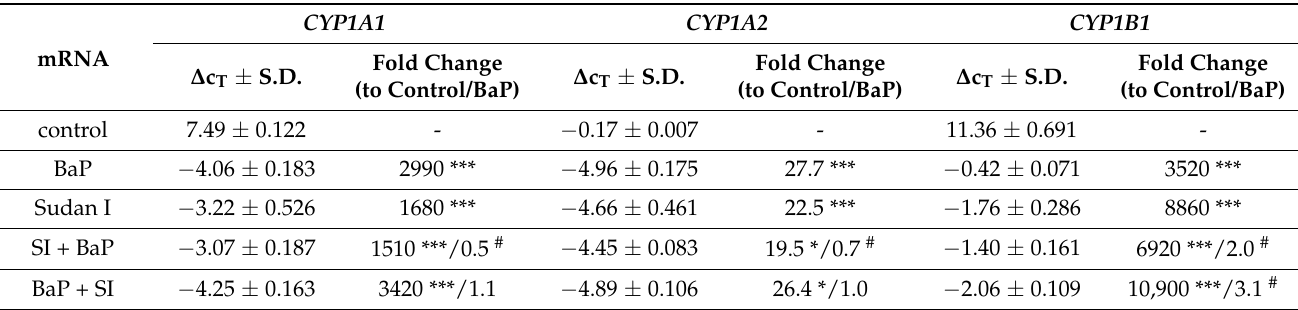
Table 1. Relative mRNA expression of CYP1A1 , CYP1A2 and CYP1B1 in livers from control (untreated) rats and rats exposed to BaP alone, Sudan I alone or Sudan I before BaP treatment (SI + BaP) or Sudan I after BaP treatment (BaP + SI). CYP1A1 CYP1A2 CYP1B1 mRNA Fold Change Fold Change Fold Change ∆ c ∆ c ∆ c ± S.D. ± S.D. ± S.D. T T T (to Control/BaP) (to Control/BaP) (to Control/BaP) control